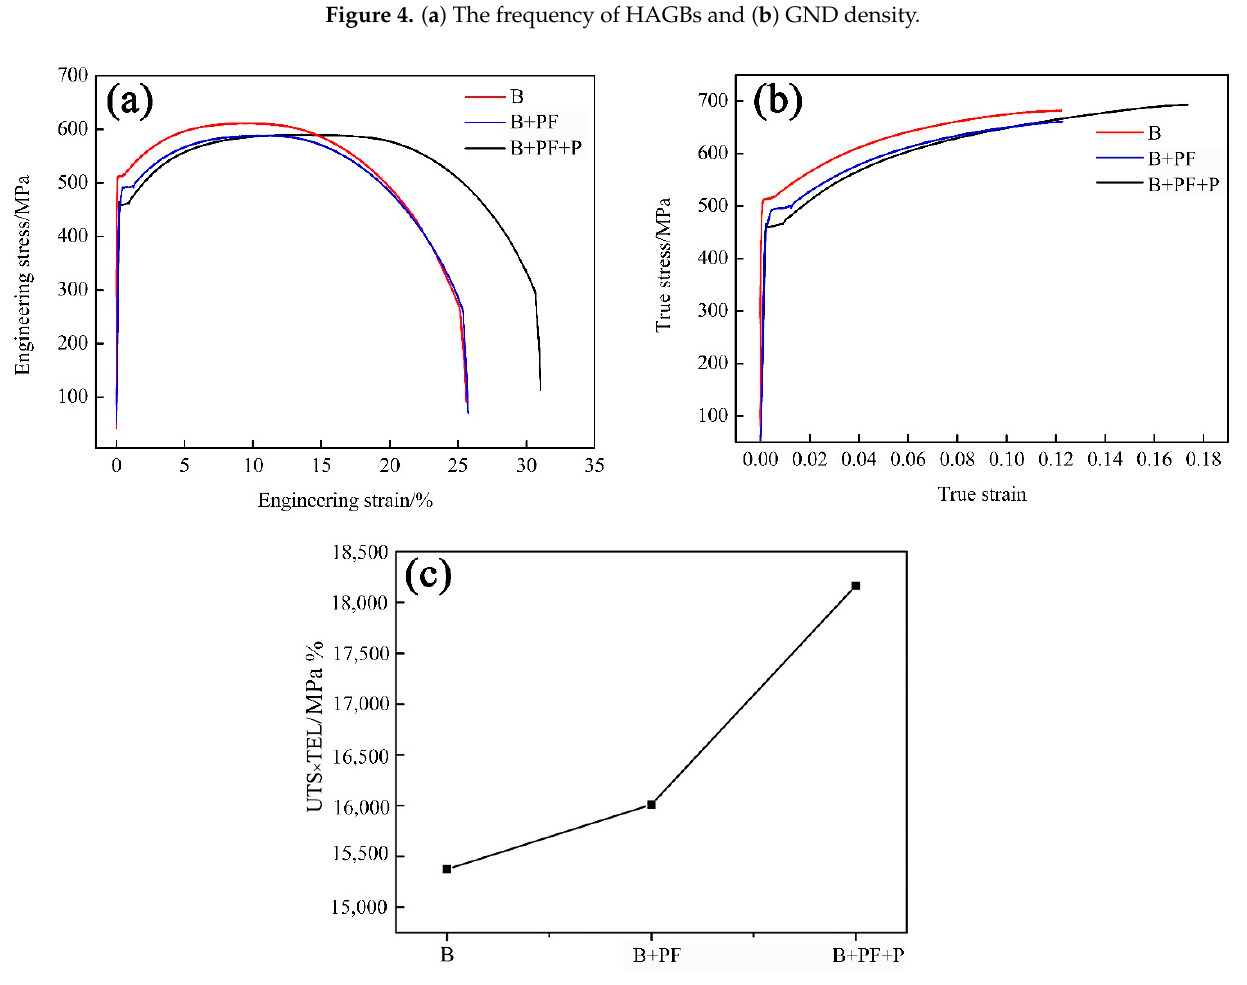
Figure 5. ( a ) Engineering stress-strain curves ( b ) true stress-strain curves, and ( c ) Table 2. Mechanical properties of three microstructures.